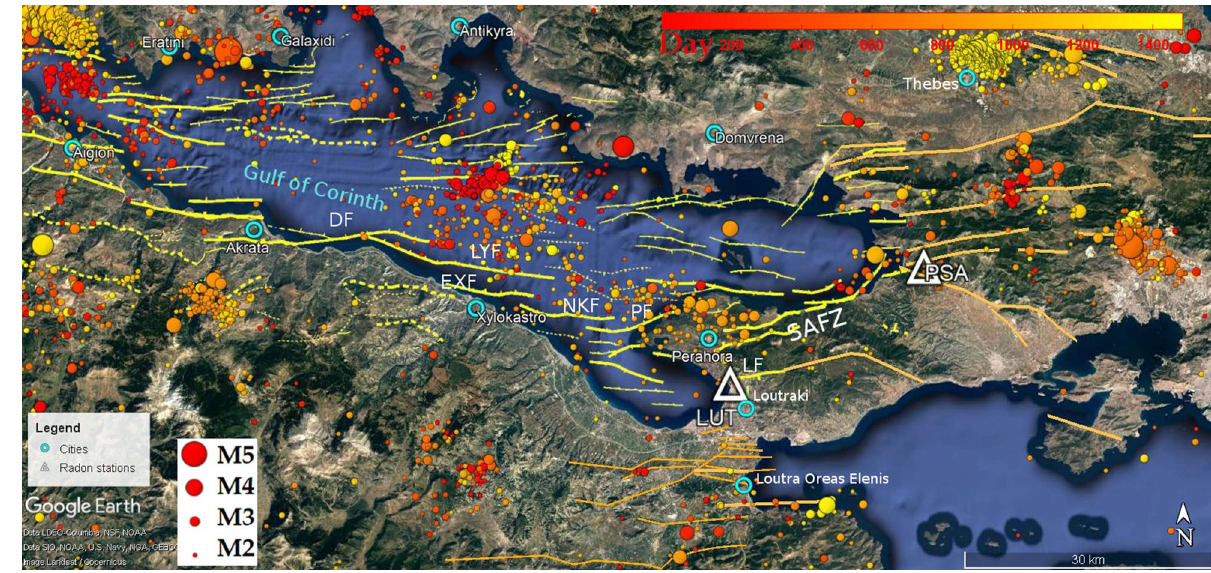
Figure 2. Fault zones of Gulf of Corinth as mapped by Nixon et al. 32 (yellow). The faults of eastern and southern area have mapped as mapped by Lekkas 35 and Ghisetti and Vezzani 36 . The north dipping North Kiato (NKF) and Perachora Faults (PF), ~ 12 km in length, form a dextral en echelon fault array with the East Xylokastro Fault (EXF) which is probably linked at depth. The South Alkyonides Fault Zone is indicated in